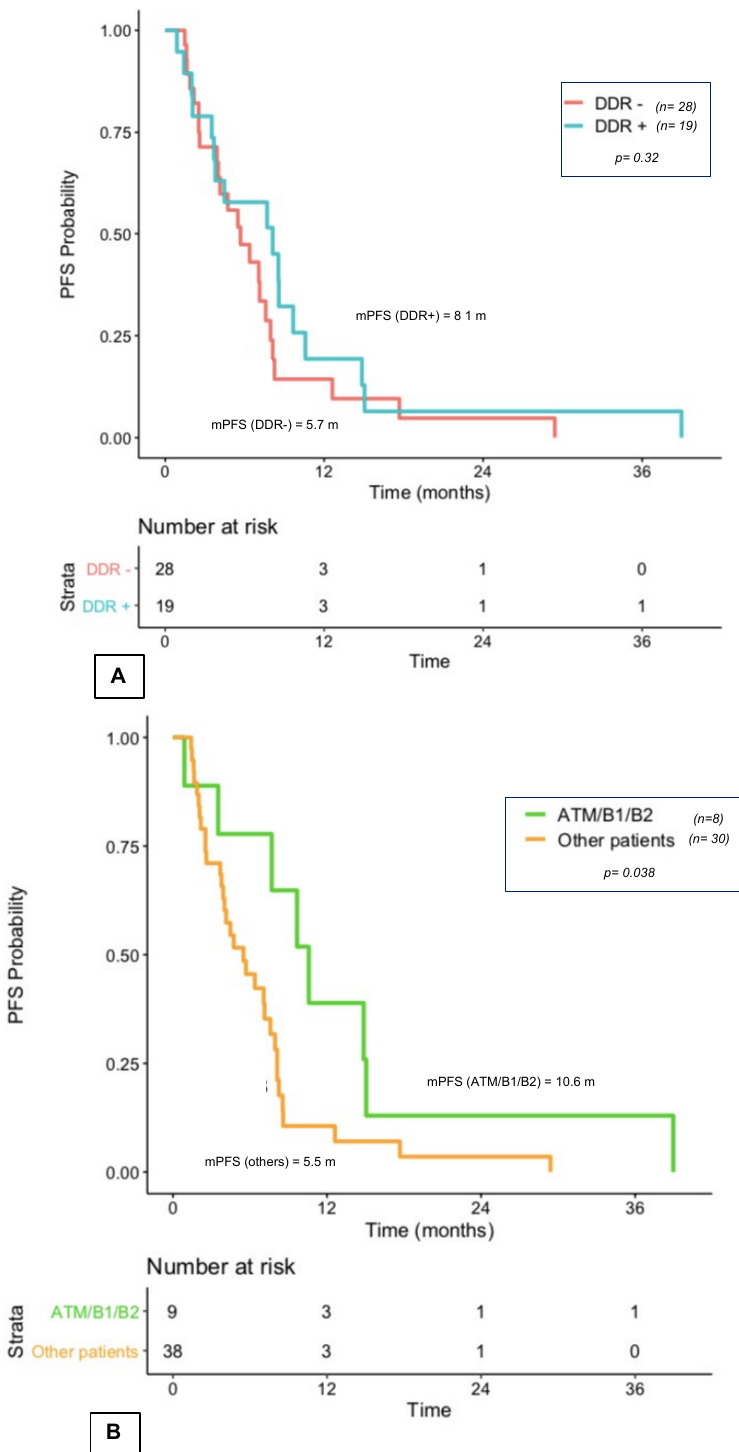
Figure 3. ( A ) First exposure to taxanes among mCRPC patients in first two lines according to somatic DDR+ versus DDR− alterations ( A ) according to ATM/B1/B2-mutated patients versus other patients. ( B ). DDR+: mutated patients, DDR−: non-mutated patients; m: months; mCRPC: metastatic castration-resistant prostate cancer; mPFS: median progression-free survival; n : number of patients. For the 74 patients who received at least one line of NHT, first exposure PFS was similar in the two groups (9.7 months for DDR+ vs. 8.3 months for DDR − ; p = 0.73; Figure S2A). In this group, PFS was 10.4 months in ATM/BRCA1/BRCA2 -mutated